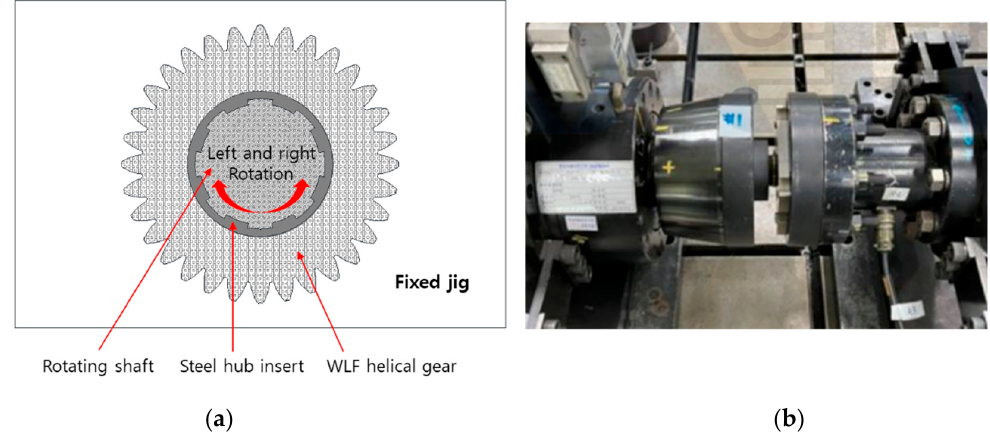
Table 4. Test conditions.